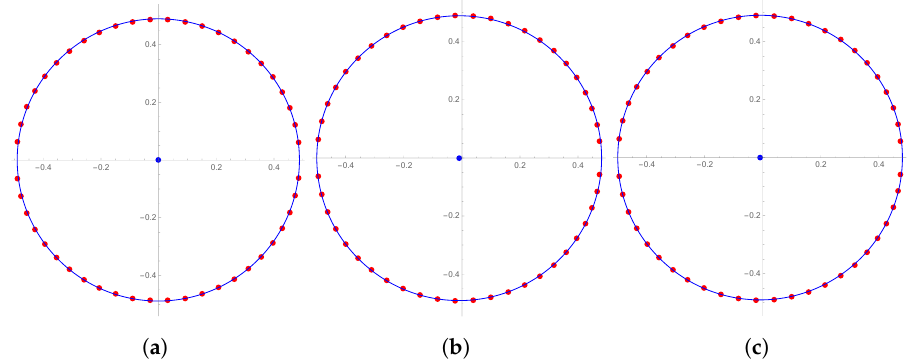
Figure 2. Approximate roots and approximated circles of S 50, q ( x ) : ( a ) q = 0.01, ( b ) q = 0.001, ( c ) q = 0.0001.